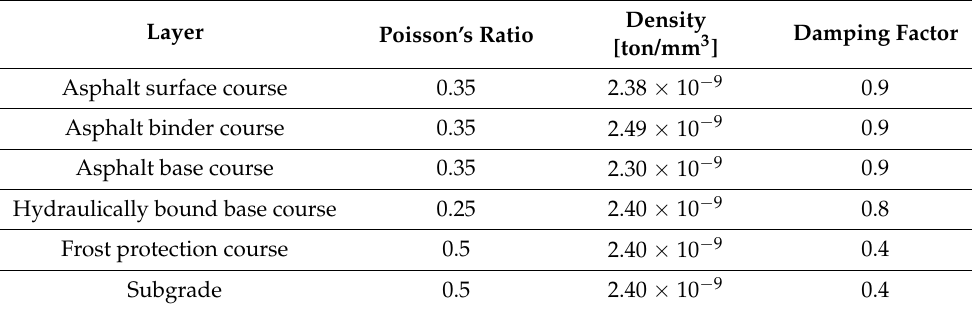
Table 3. Thickness and material properties of the pavement